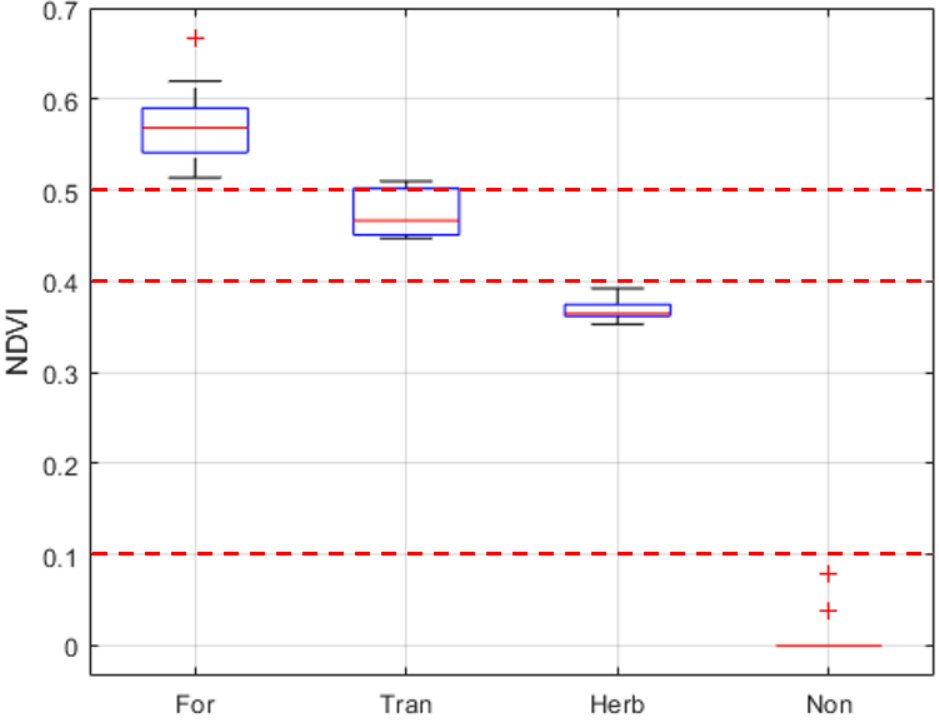
Figure 3. Box plots of NDVI for forested wetlands (For), transitional forested wetlands (Tran), emergent herbaceous wetlands (Herb), and non-vegetated areas (Non), respectively. Red horizontal dash lines represent thresholds (0.5, 0.4, 0.1) between different wetland types. The red solid horizontal line, box, and whisker ends indicate the median, 25th and 75th percentiles, and the 10th and 90th percentiles, respectively. The data points outside the ranges are shown by the red plus (+)